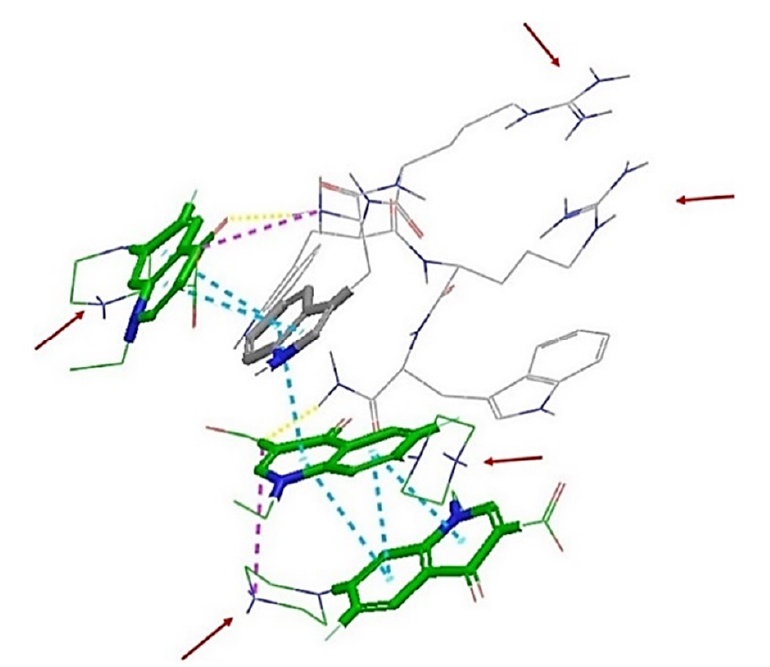
Figure 4. Intermolecular interactions observed in the complex formed between norfloxacin and peptide 6 (WRWRW-NH 2 ) at the end of 50 ns molecular dynamics (MD) simulation. A conjugation system formed by a series of π -stacking interactions (blue) is formed between the quinolone rings of three norfloxacin molecules and the indole ring of Trp1 of the peptide. The complex is further stabilized by salt bridges (purple) and hydrogen bonds (yellow). The positively-charged side chains of the arginine residues extend out from the complex; this, along with the protonated piperazine rings (positive charges are indicated by the red arrows), confers a hydrophilic character to the complex, possibly preventing this complex from entering through self-promoted